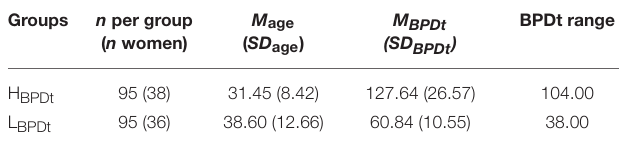
TABLE 5 | Descriptive statistics for comparison groups in experiment